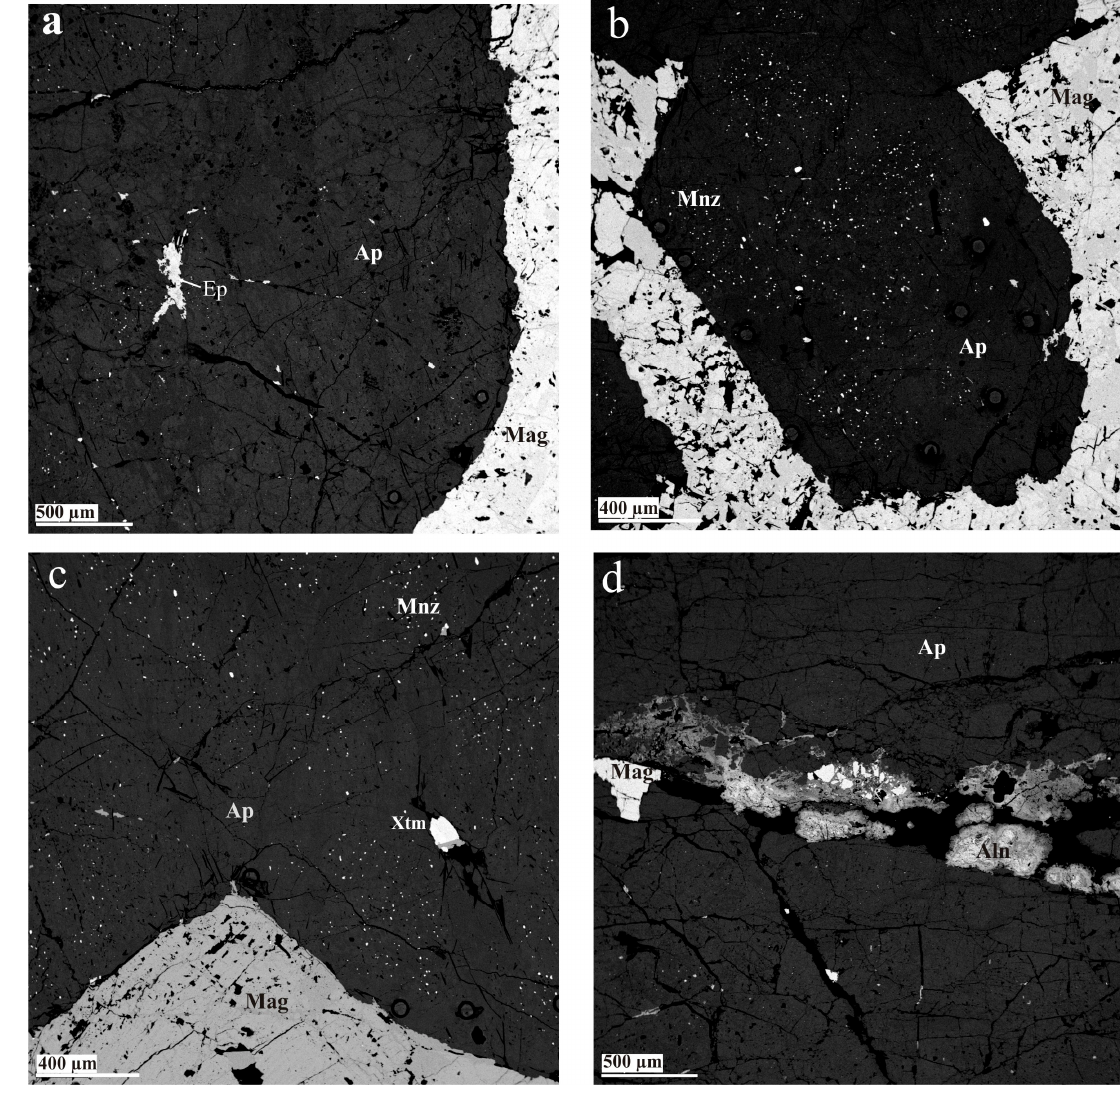
Figure 5. SEM-BSE images of apatite from MAV-host rocks in the Chadormalu iron ores. ( a ) Irregular dark and bright areas in apatites; ( b ) Euhedral apatites with monazite inclusions. Larger monazite grains might have been formed due to an Ostwald ripening like process; ( c ) Fine monazite and a large xenotime inclusions (bright) dispersed in the apatite; ( d ) Magnetite and allanite crystals situated along a crack in apatite. Abbreviations: Ap = apatite; Mag = magnetite; Mnz = monazite; Xtm = xenotime; Aln = allanite; Ep = epidote.